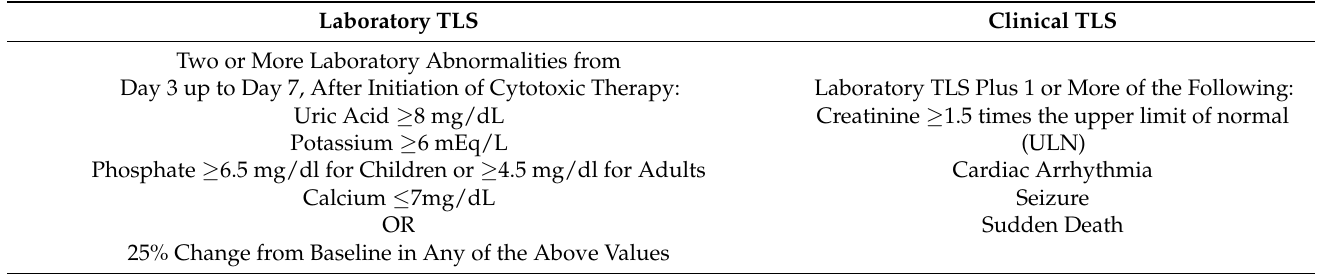
Table 4. Cairo-Bishop’s definition for laboratory and clinical tumor lysis syndrome